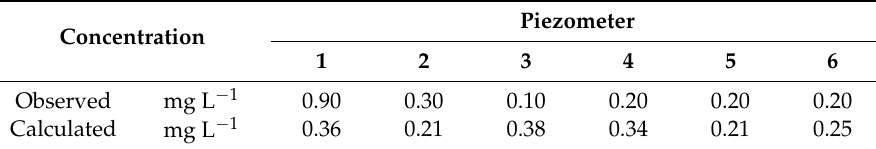
Table 3. Observed and calculated nitrate